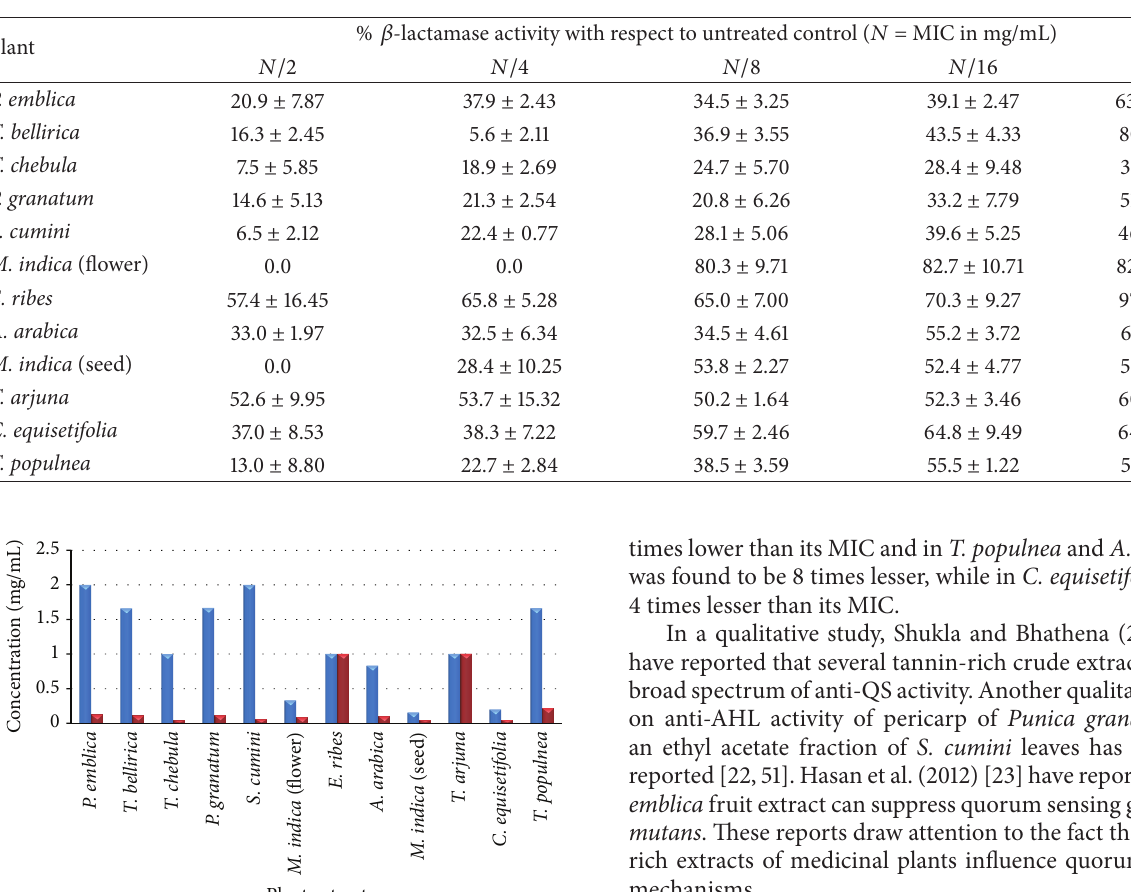
Figure 2: luxI and luxR effect: extract prepared from P. granatum affects production as well as activity of the autoinducer (a). Extract prepared from C. equisetifolia is unable to affect either production or binding of the autoinducer (b) (1: luxR effect, 2: luxI effect). Table 3: Quantitative studies of anti-quorum sensing activity detected as 𝛽 -lactamase activity in biosensor strain S. aureus agr P3:: blaZ in the presence of subinhibitory concentrations of plant extracts.